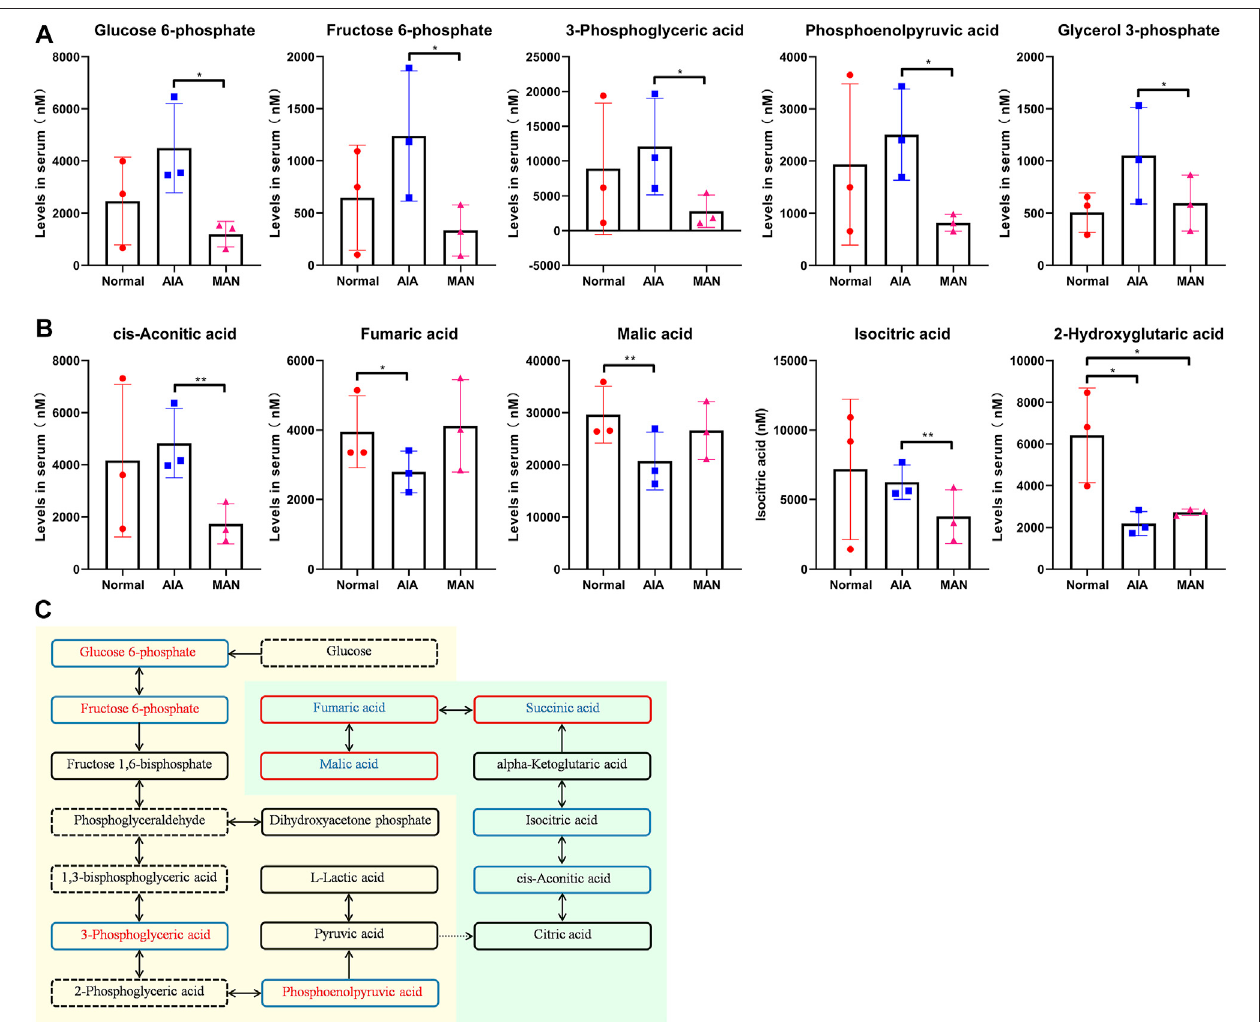
FIGURE5| MANrebalancedglycolysisandaerobicoxidationinAIArats. (A) ,levelsofglycolysis-relateddifferentiatingmetabolitesamonggroups( n (cid:2) 3),andallthe metabolites shown in this and following images were detected by LC-MS in plasma obtained upon the sacri fi ce of rats; (B) , levels of aerobic oxidation-related differentiating metabolites among groups ( n (cid:2) 3); (C) , changes of metabolic fl ow occurred in AIA and MAN-treated AIA rats (dotted line indicated undetected compounds, colors of the frame indicated MAN-brought changes, colors of the text indicated AIA-related changes, blue and red colors indicated down-regulation and up-regulation